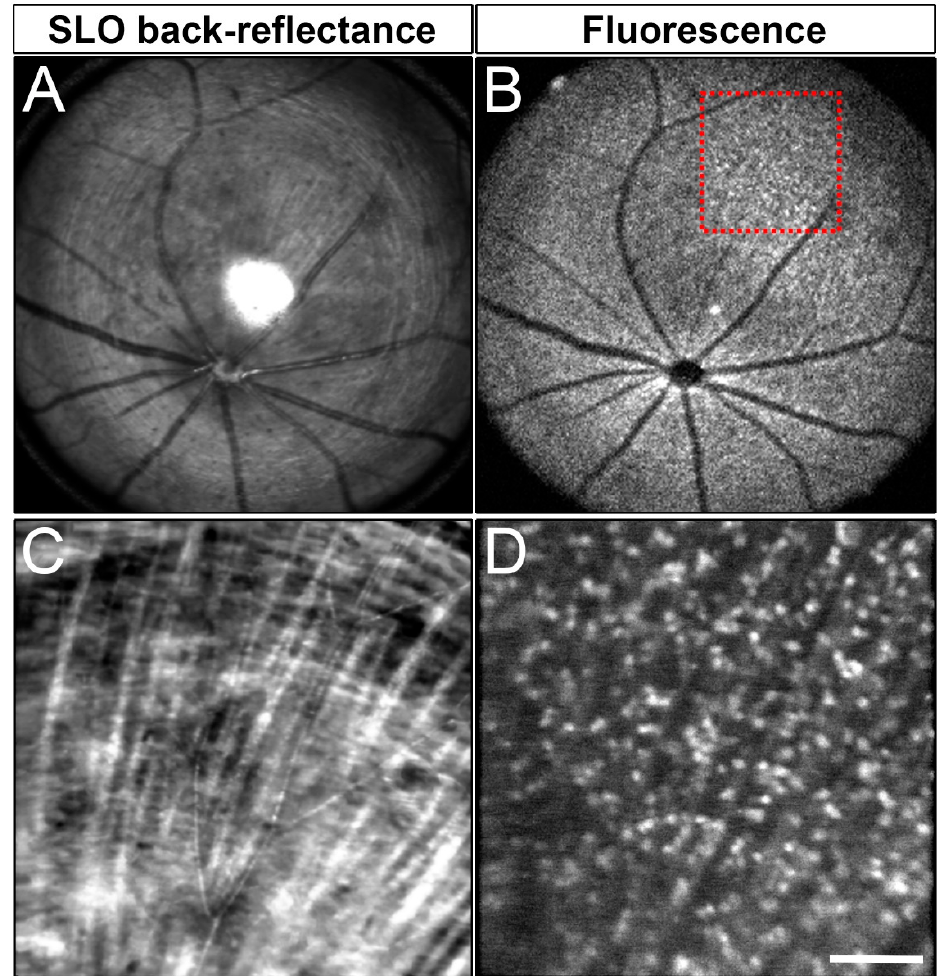
Figure 5. SLO imaging of a Brn3b-mCherry adult retina. ( A ) SLO back reflectance of a roughly 2mm width of an adult Brn3b-mCherry adult retina. ( B ) Fluorescent signal from the same region shown in A. ( C ) SLO back-reflectance image of the region of interest marked by a red square in B. ( D ) Fluorescent signal from the red square marked in B. Scale bars: 400 microns in A and B, and 100 microns in C and D.